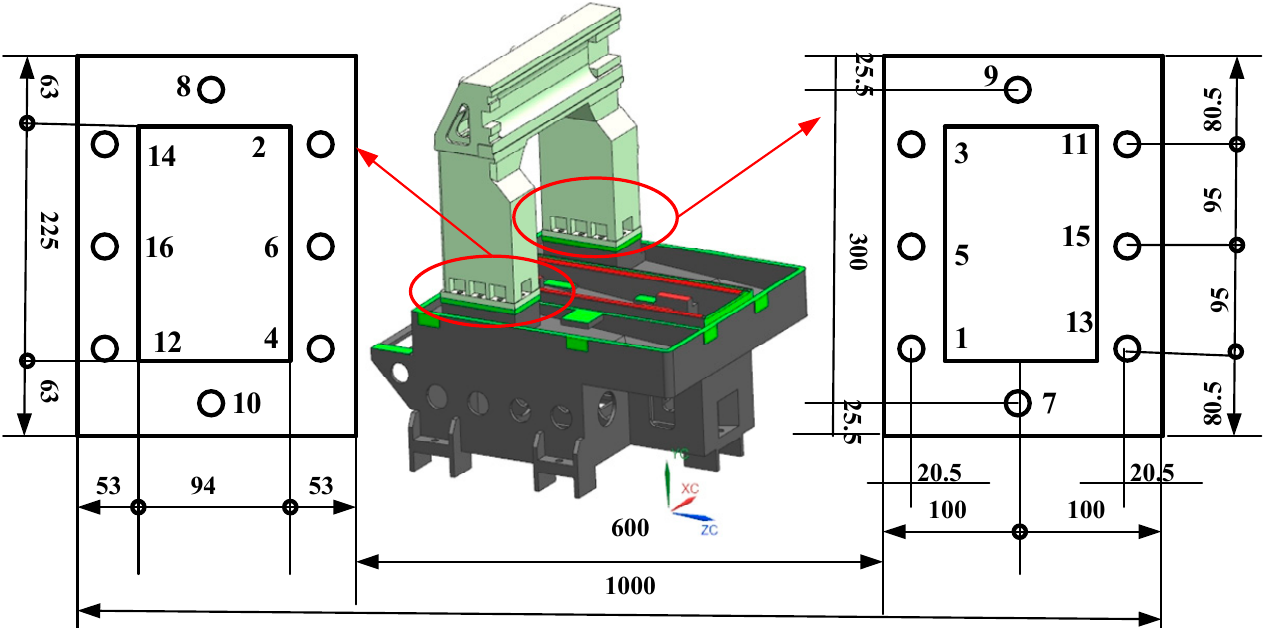
Figure 14. Frame of engraving machine and the distribution of bolts (with the unit of mm). The connect condition of the bolts is listed in Table 10. Table 10. Connect condition of the bolts.